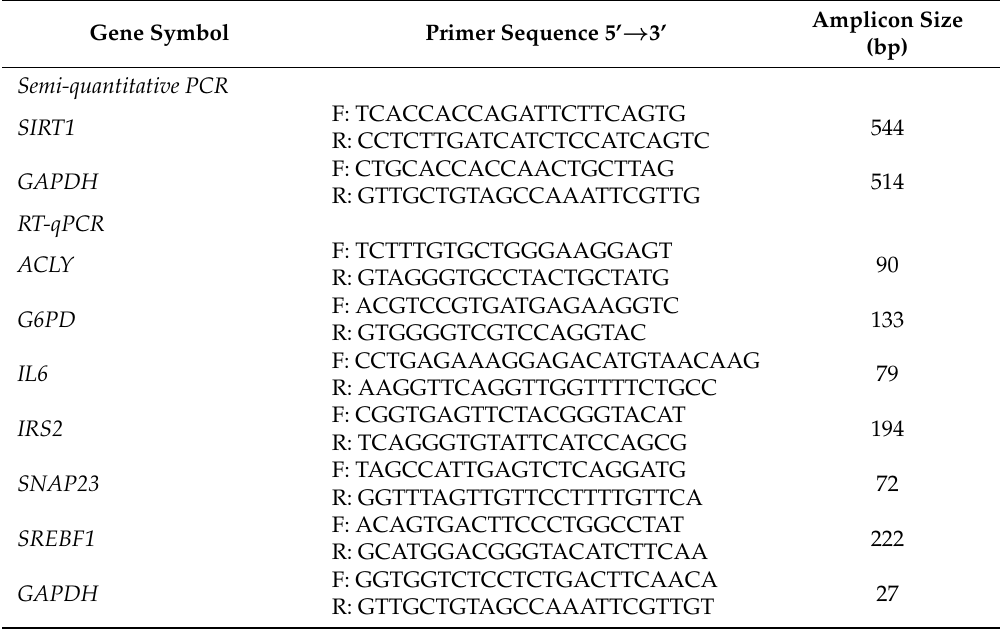
Table 8. Primer sequences used for PCR